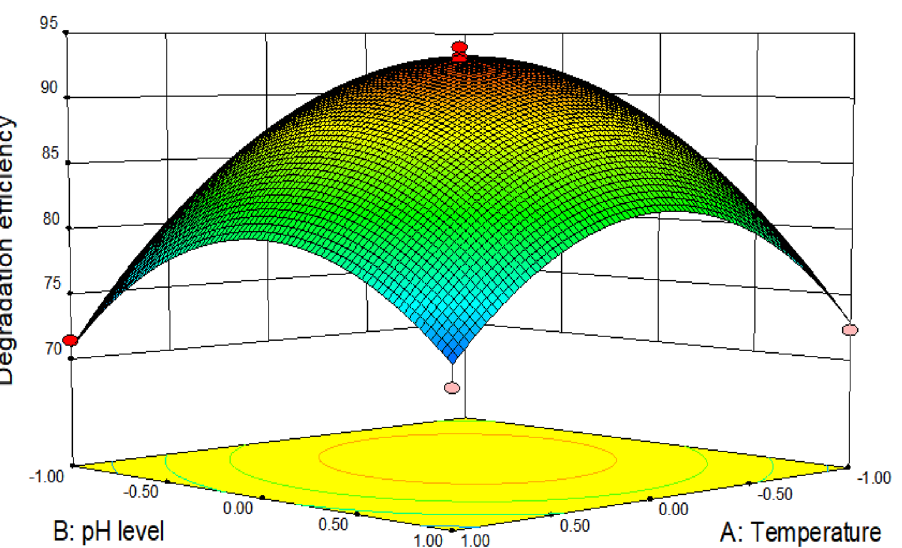
Figure 5. Response surface curves demonstrating the effects of medium temperature (°C) and pH level on SMX biodegradation efficiency (%) with an inoculum amount of S. mizutaii LLE5 at 3.5 × 10 7